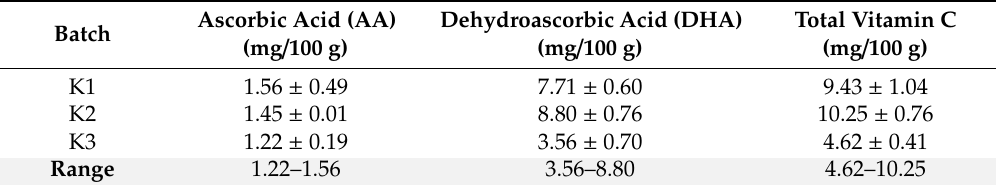
Table 4. Vitamin C values (mg / 100g fw) of deastringed persimmon fruits (‘Rojo Brillante’ variety) analysed in the 2017 season. Results expressed as mean ± standard deviation ( n -1), n =